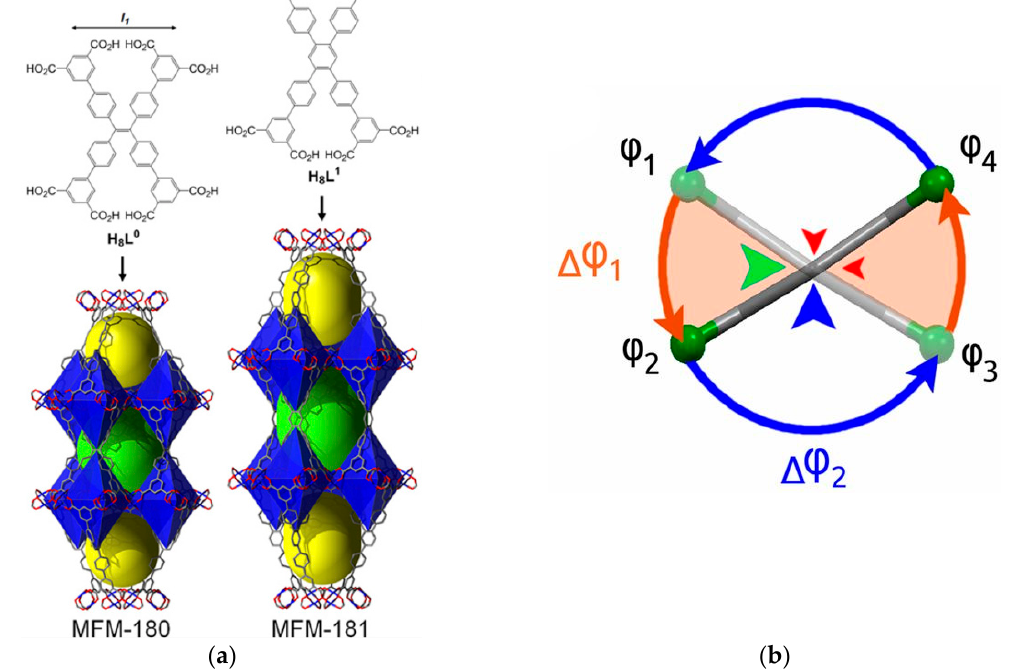
Figure 6. ( a ) Structure of MFM-180 and MFM-181 and their respective linkers; ( b ) rotational trajectory of the para -phenylene rotators. Reproduced from [9].